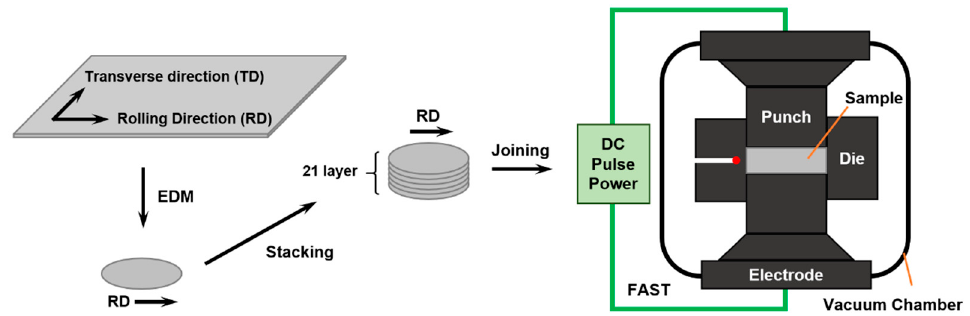
Figure 1. The process flow chart of the W foil laminates preparation.